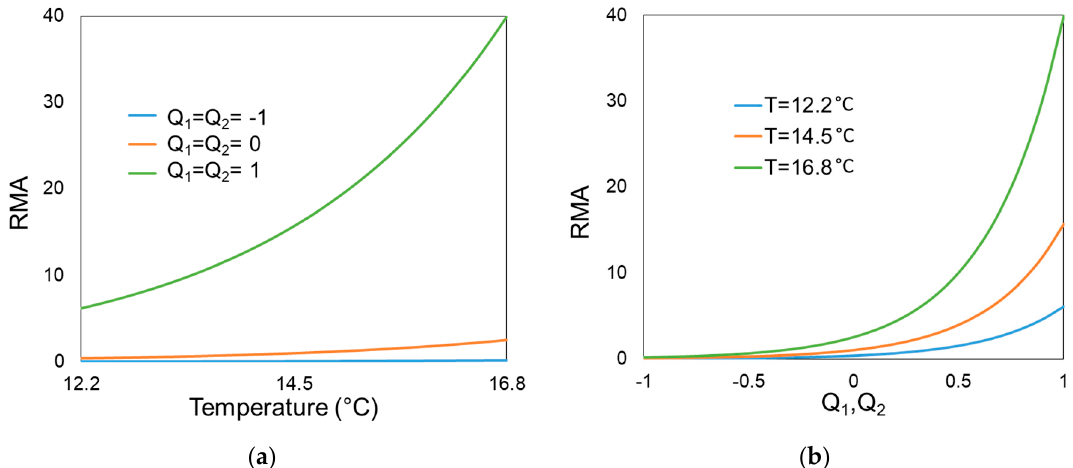
Figure 2. Relative mosquito abundance (RMA) as a function of ( a ) mean temperature (T) 1-7 days before evaluation time t, and ( b ) maximum standardized river flows (in associated standard deviations) Q 1 and Q 2 at time periods 36-42 days and 22-28 days, respectively, before time t. The results in (a) are for different Q 1 and Q 2 values (in associated standard deviations) and the results in (b) are for different T values. All Q 1 , Q 2 , and T values considered are within their respective observation-based value ranges.